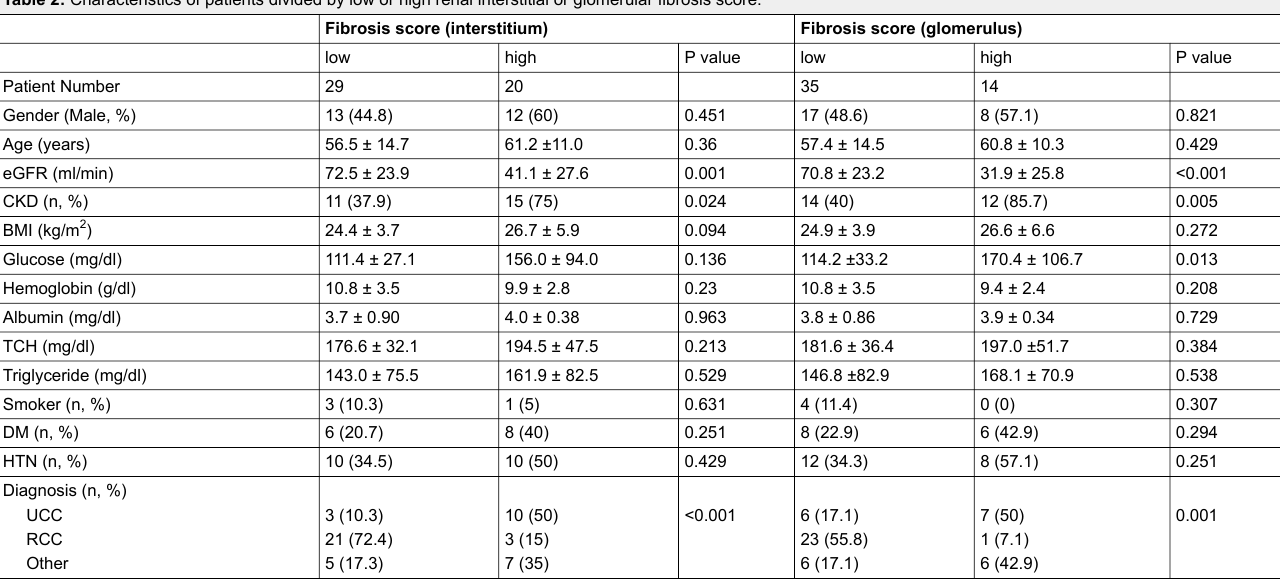
eGFR, estimated glomerular filtration; CKD, chronic kidney disease; BMI, body mass index; TCH, total cholesterol; DM, diabetes mellitus; HTN, hypertension; UCC, urothelial cell carcinoma; RCC, renal cell carcinoma p < 0.05 indicates